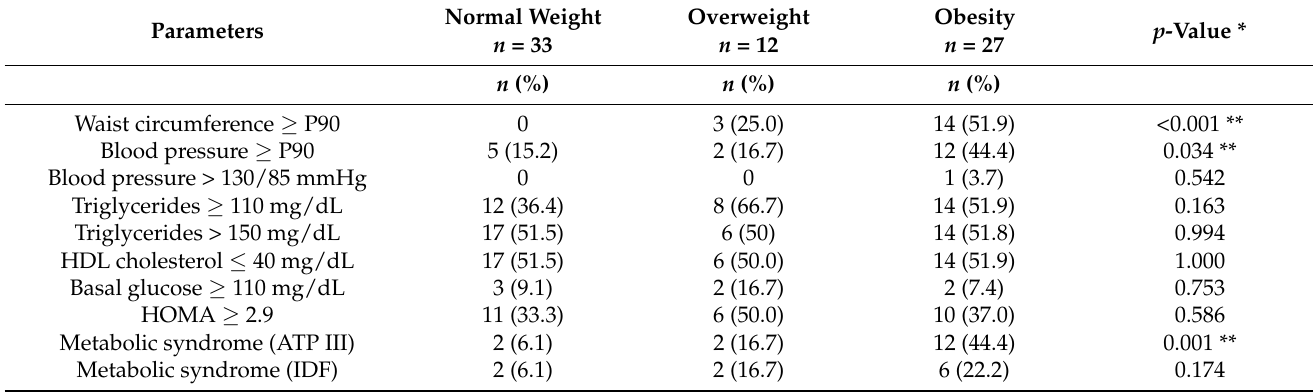
Table 4. Components of metabolic syndrome according to nutritional status in Huatusco, Ver- acruz,